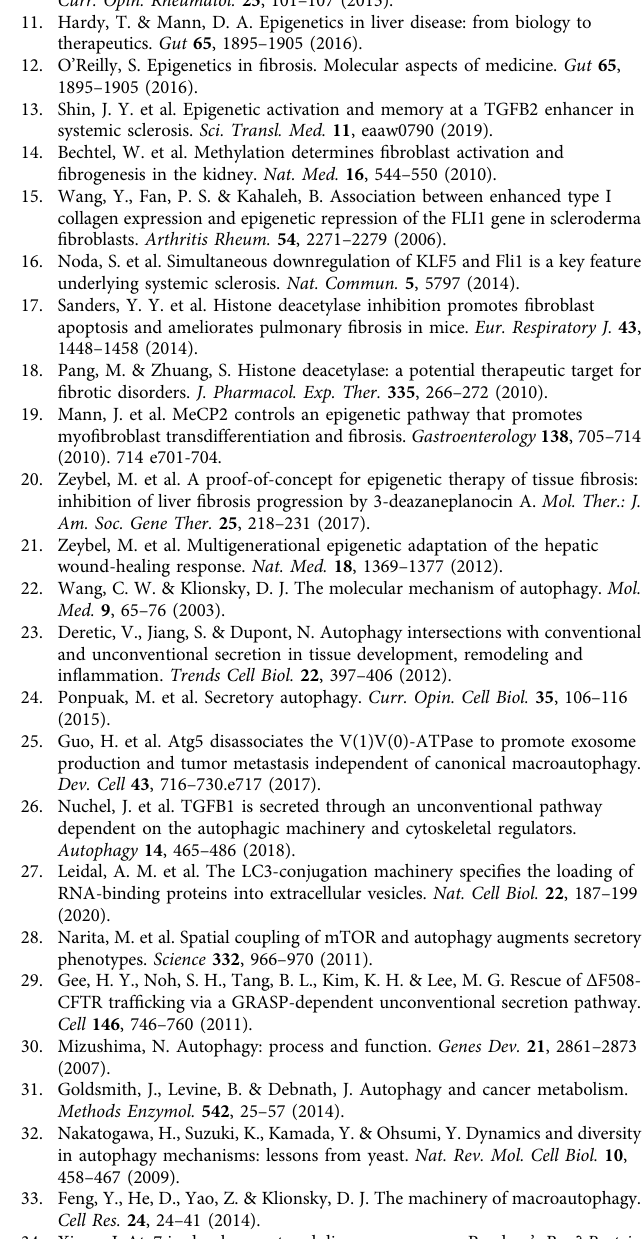
Fig. 8 Re-expression of MYST1 inhibits TGF β -dependent fi broblast activation and prevents experimental fi brosis. a , b Overexpression of MYST1 in cultured human dermal fi broblasts: a Expression of α SMA ( n = 4 biological replicates per group) and formation of stress fi bers ( n = 5 biological replicates per group). Representative images and quanti fi cation. Horizontal scale bar, 100 µ m. b mRNA levels of COL1A1 analyzed by qRT-PCR ( n = 5 biological replicates per group), total collagen as analyzed by hydroxyproline assays ( n = 4 biological replicates per group) and type I collagen protein as analyzed by western blot ( n = 5 biological replicates per group). c – e Adenoviral overexpression of MYST1 in murine models. c T β RIact-induced skin fi brosis: Representative trichrome stainings for, dermal thickening, myo fi broblast counts and hydroxyproline content ( n = 4 biological replicates per group). d Bleomycin-induced pulmonary fi brosis: Representative Trichrome stainings, fi brotic area, myo fi broblast counts, Ashcroft scores and hydroxyproline content ( n = 4 biological replicates for the group AdMyst1 treated with TGF β and n = 3 for other groups). e Bleomycin-induced dermal fi brosis: Representative trichrome stainings shown, dermal thickening, myo fi broblast counts and hydroxyproline content ( n = 4 biological replicates for bleomycin treated groups and n = 3 for saline treated groups). Horizontal scale bars, 100 µ m. All data are presented as median ± IQR. p -values were determined by ANOVA one-way with Tukey ’ s multiple comparison post hoc test and are indicated in the fi gure. See source data for more detailed information. rel.: relative, Ad: adenovirus, conc.: concentration, int.: intensity, T β RIact: constitutively active TGF β receptor type I,